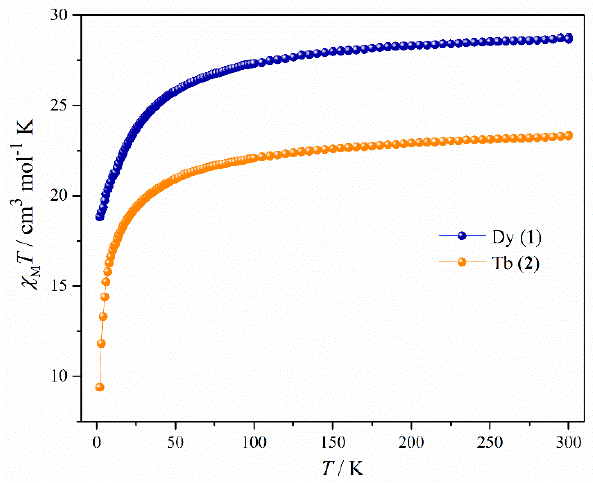
Figure 2. Temperature dependence of the χ M T products in 1000 Oe for complexes 1 and 2 .